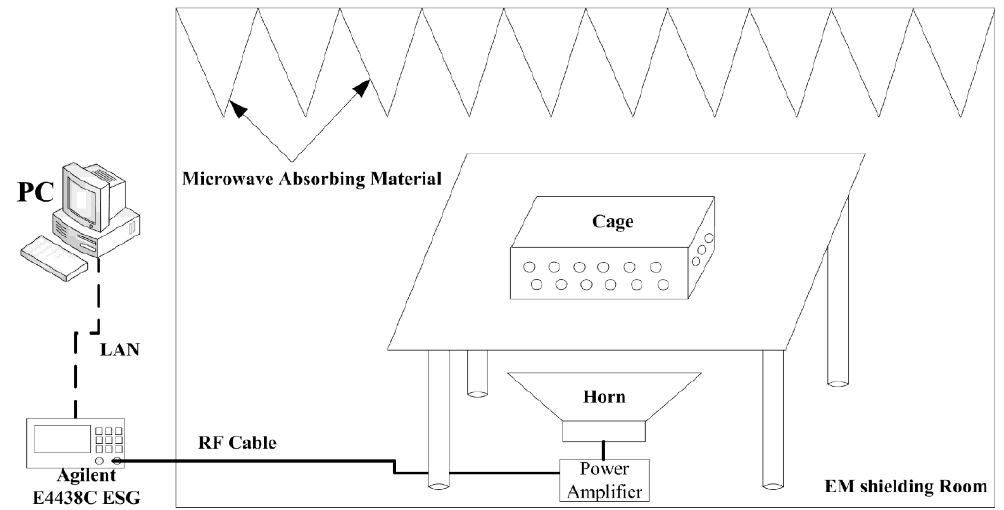
Figure 1. Schematic diagram of 1.8 GHz microwave exposure